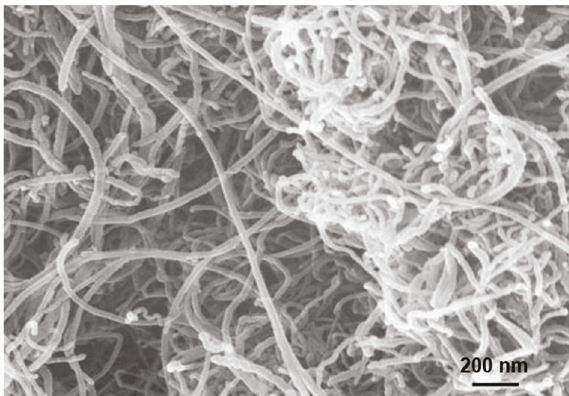
Figure 1: FE-SEM image of multiwalled carbon nano tubes.